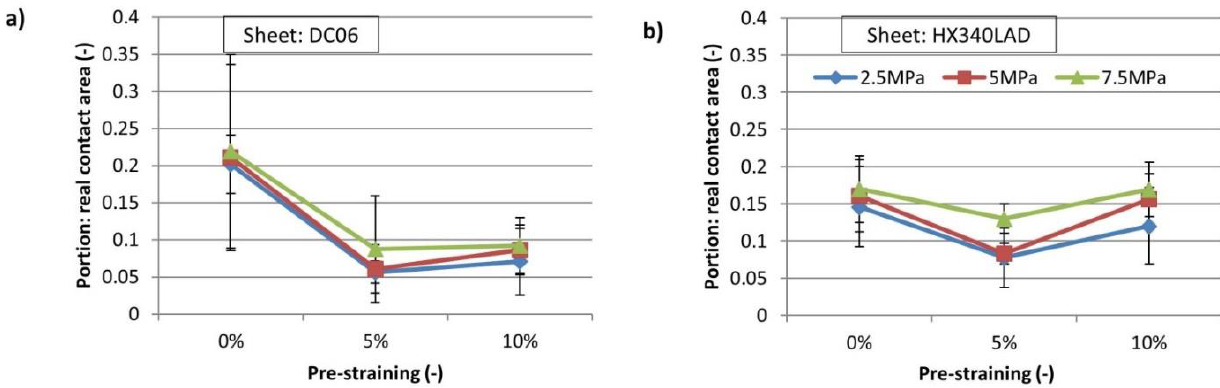
Figure 19. Portion of real contact area with variable contact stress under the sliding speed 25mm/s: ( a ) DC06; ( b ) HX340LAD.